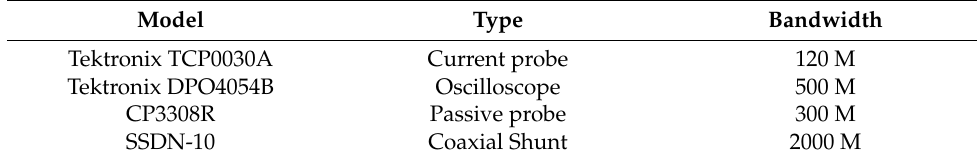
Figure 9. DC-side snubber testing platform. Table 2. Test equipment used in the